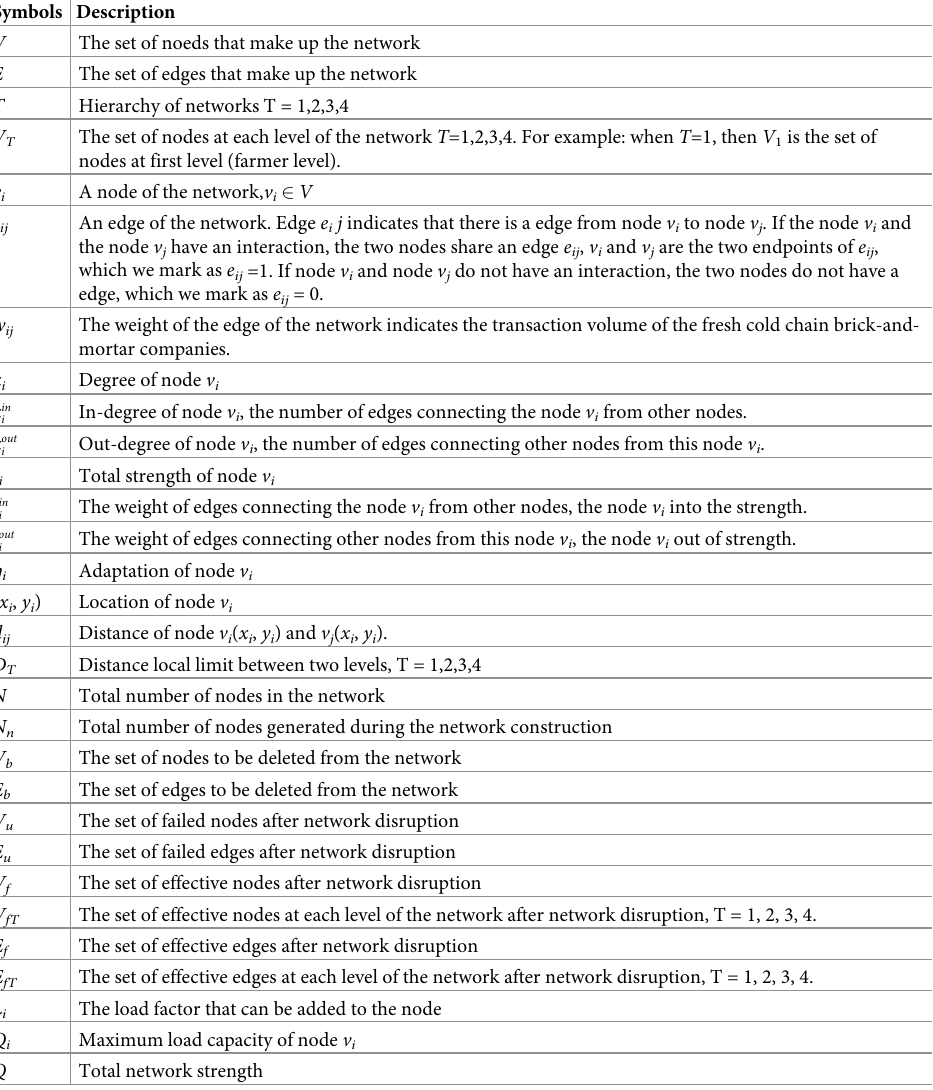
Table 1. Description of the main symbols. Symbols Description